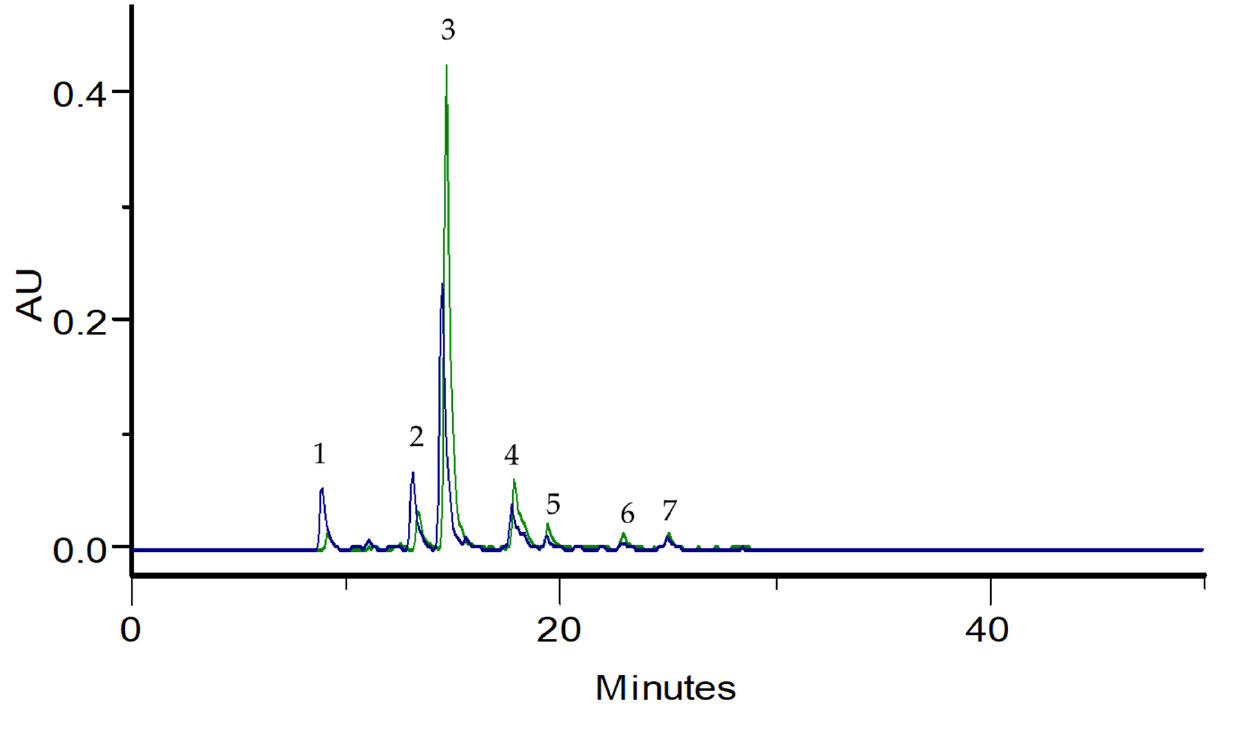
Figure 1. HPLC-PDA profiles of Crithmum maritimum L. infusion (green line) and decoction (blue line), recorded at 320 nm. Peaks 1–3 and 5–7 are caffeic or ferulic acid derivatives. Peak 4 is a p -coumaric acid derivative.